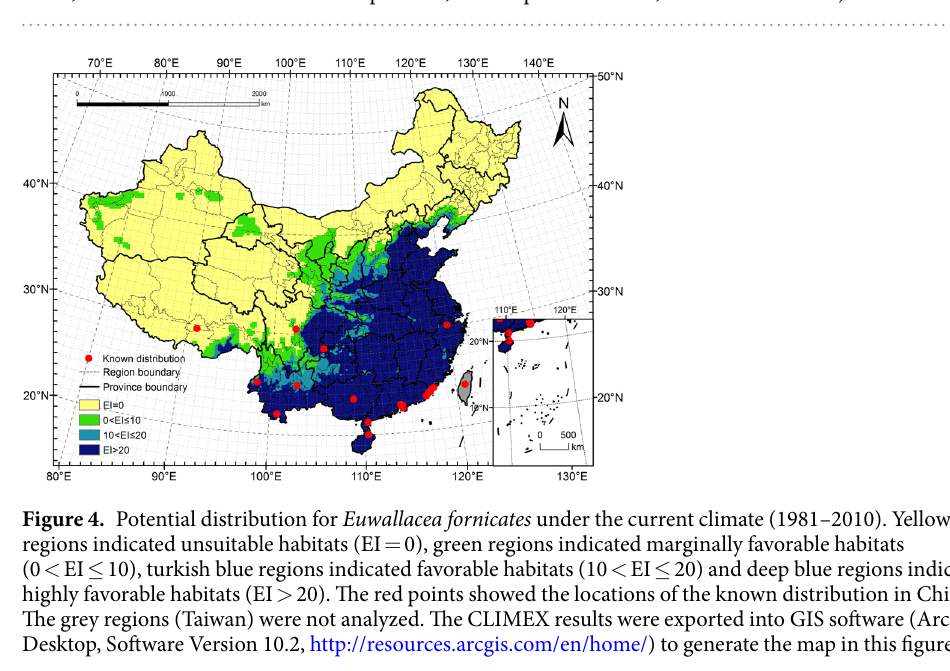
Figure 3. Impact Index in different provinces of the four factors. The range of the index is 0–10. (CS-Cold stress, PDD-Effective accumulated temperature, TI-Temperature Index, MI-Mositure Index).